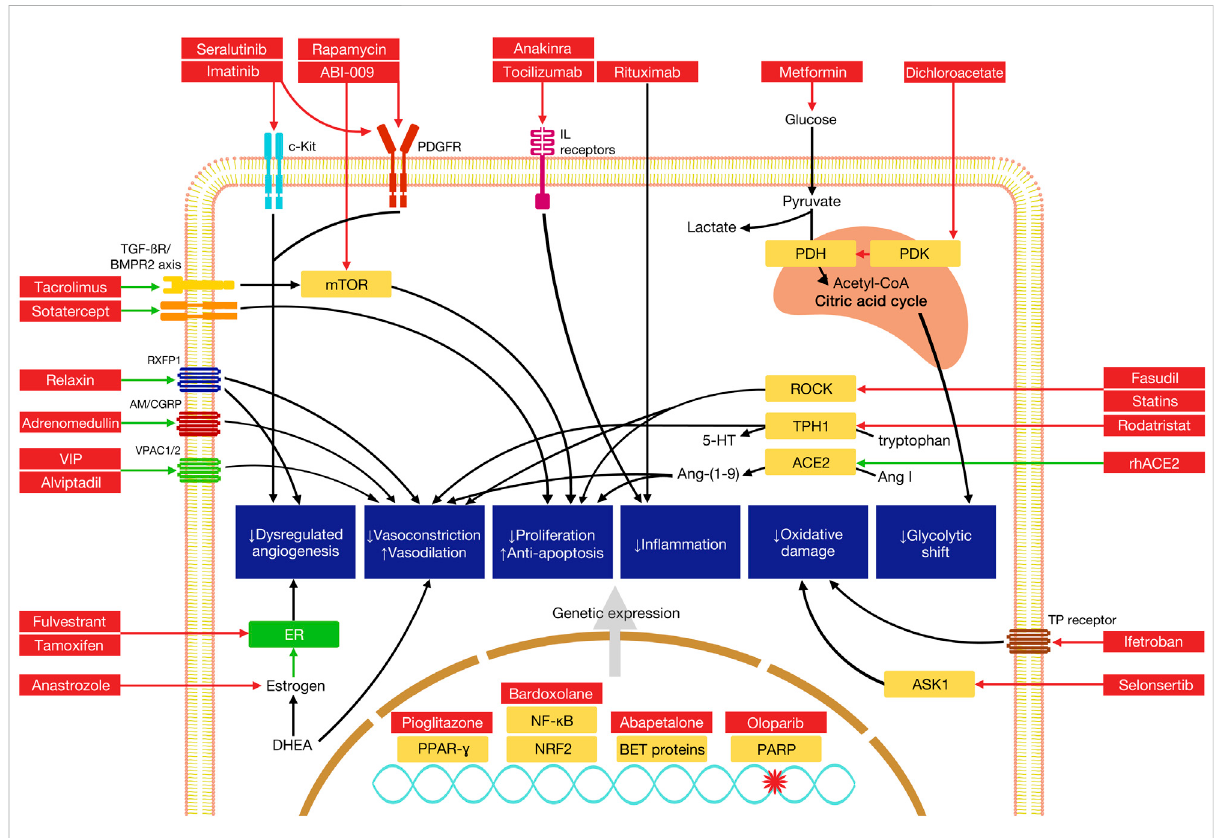
FIGURE 2 Mechanisms of selected novel therapies in the treatment of pulmonary arterial hypertension. Green arrows indicate pathway stimulation; red arrows indicate inhibition. Some pathways have been simpli fi ed for the purposes of depiction within the diagram. AM, adrenomedullin receptor; ASK1, apoptosis signal-regulating kinase 1; BET, bromodomain and extaterminal domain; BMPR2, bone morphogenetic protein receptor 2; CGRP, calcitonin gene-relatedpeptide; mTOR,mammalian target ofrapamycin; NF- κ B,nuclear factor kappa lightchain enhancer ofactivated Bcells; Nrf2, nuclear factor erythroid 2-related factor 2; PARP, poly (ADP-ribose) polymerase; PDH, pyruvate dehydrogenase; PDGFR, platelet-derived growth factor receptor; PDK, pyruvate dehydrogenase kinase; PPAR- γ , peroxisome proliferator activated receptor gamma; ROCK,